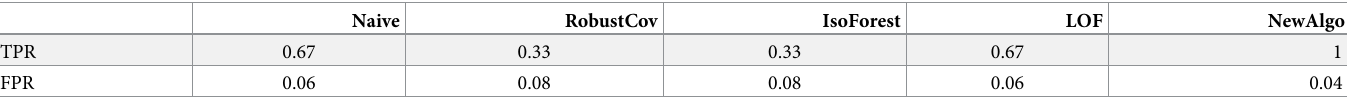
Table 6. The true positive and false positive rates of the anomaly detection algorithms. The results represent experiments on a single real-life dataset. The proposed method ( NewAlgo ) produces the best overall